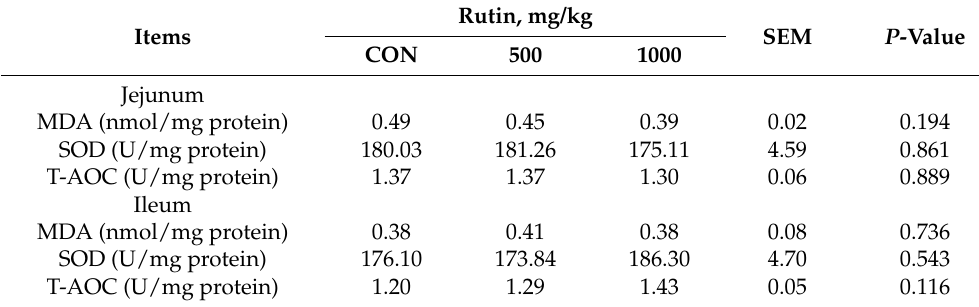
Table 5. Effect of rutin on the intestinal antioxidant status of aged laying hens.